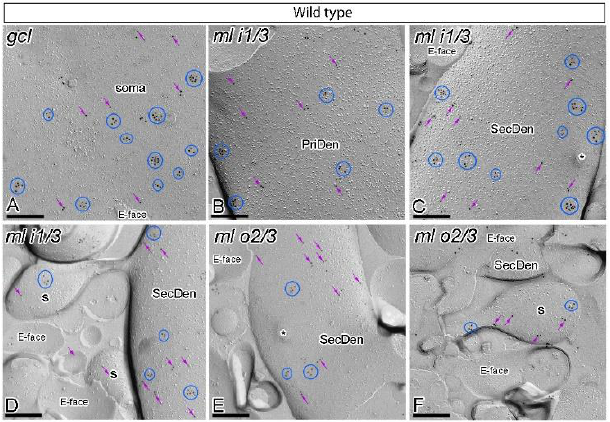
Figure 2. Subcellular localisation of GABA B1 in somato-dendritic domains of granule cells in wild type mice. ( A – F ) Electron micrographs obtained from di ff erent parts of the DG showing immunoparticles for GABA B1 along the surface of granule cells, as detected using the SDS-FRL technique in wild type mice at 12 months of age. Immunoparticles for GABA B1 were detected forming clusters (blue ellipses / circles) or scattered (purple arrows) associated with the P-face in the soma, primary dendrites (PriDen), secondary dendrites (SecDen) and dendritic spines (s) of both the outer two thirds (ml o2 / 3) and inner one third (ml i1 / 3) of the molecular layer. Fractured spine necks are indicated with asterisks (*). The E-face is free of any immunolabelling. Scale bars: A – F , 0.2 µ